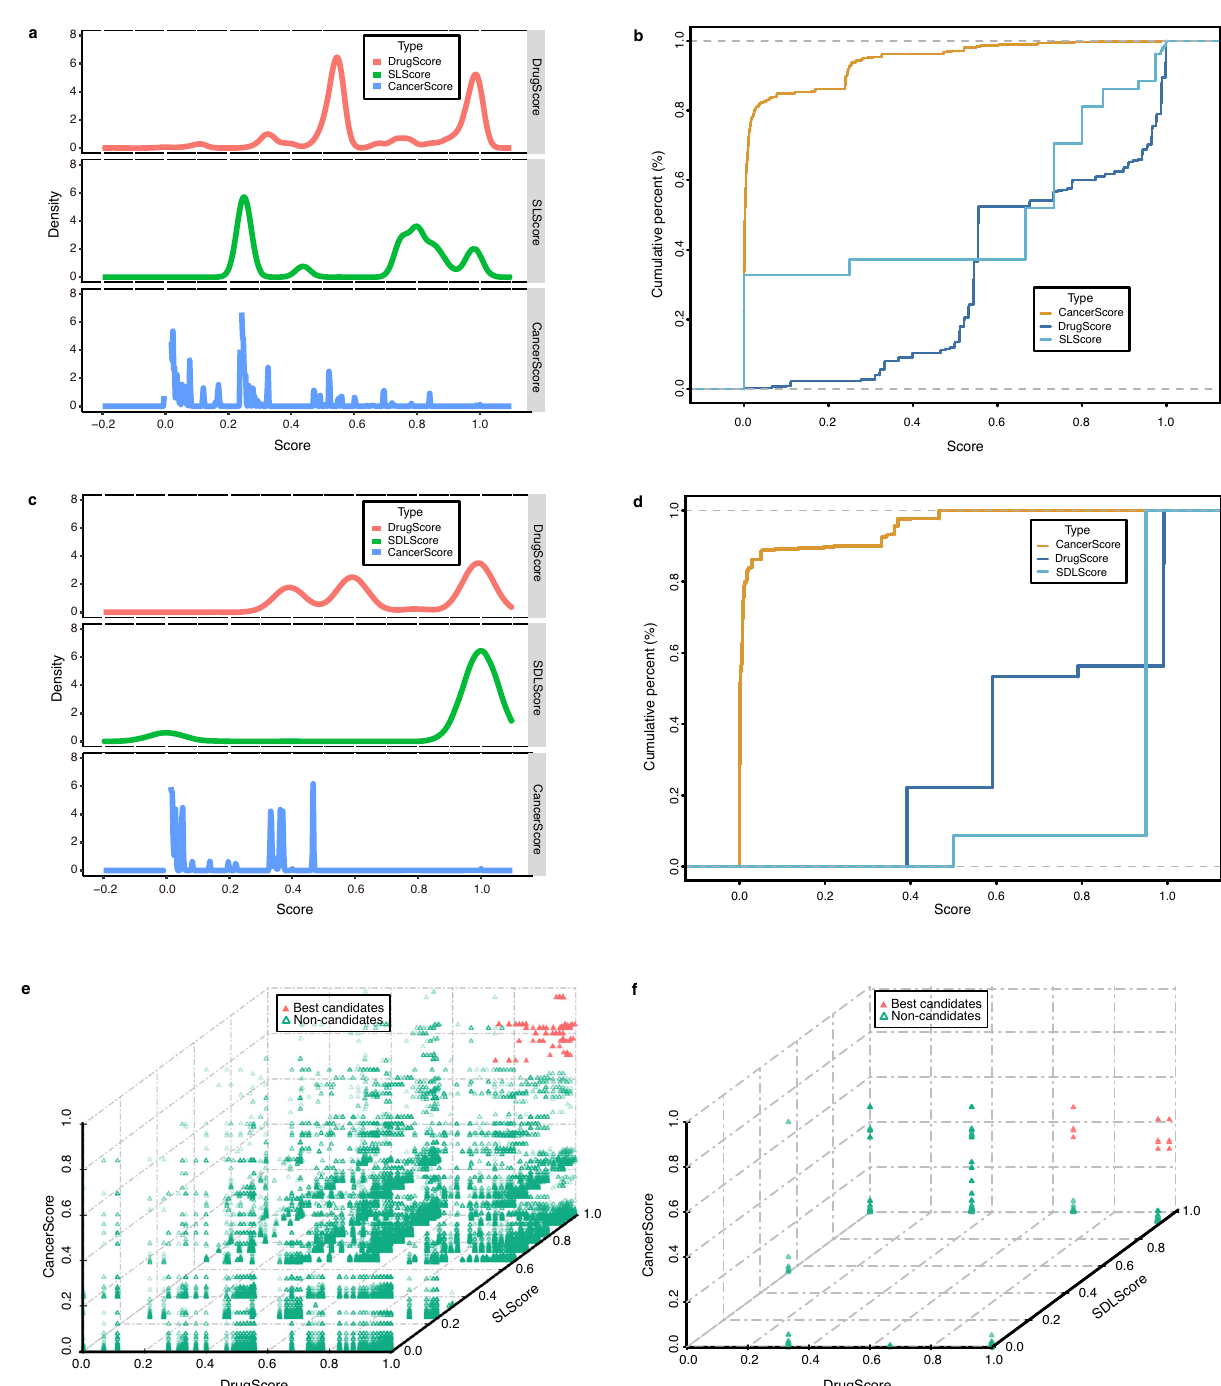
Fig. 3 Distribution of three scores and top candidates. a Probability distribution curve of the three scores in SL. Lines indicate DrugScore (red), SLScore (green), and CancerScore (blue). b Cumulative distribution curve of the three scores in SL. Lines indicate CancerScore (yellow), DrugScore (dark blue), and SLScore (sky blue). c Probability distribution curve of the three scores in SDL, same as SL. d Cumulative distribution curve of the three scores in SDL, same as SL. Three-dimensional graph of drug repositioning results for best repurposable drug candidates (red solid triangle) and non-candidates (green hollow triangle) based on SL ( e ) or SDL ( f